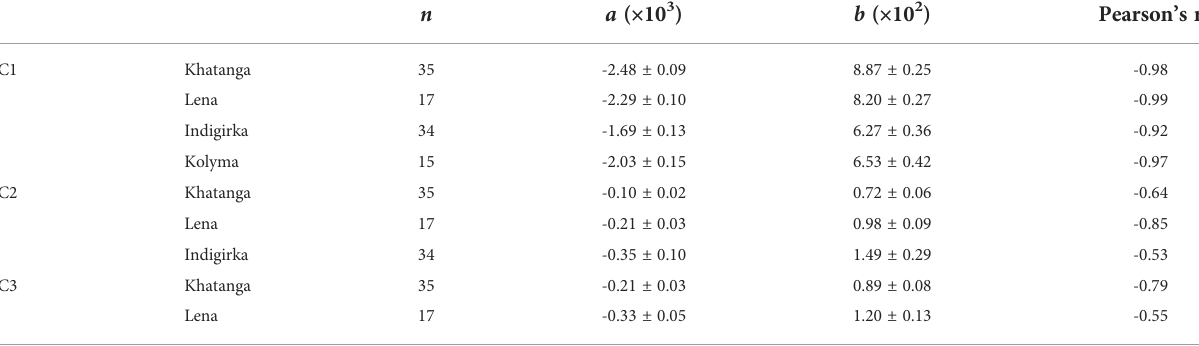
TABLE 4 Summary of regression analysis for PARAFAC components C1-C3 against salinity in the Khatanga, Lena, Indigirka, and Kolyma transects: n - number of samples, a – slope, b -